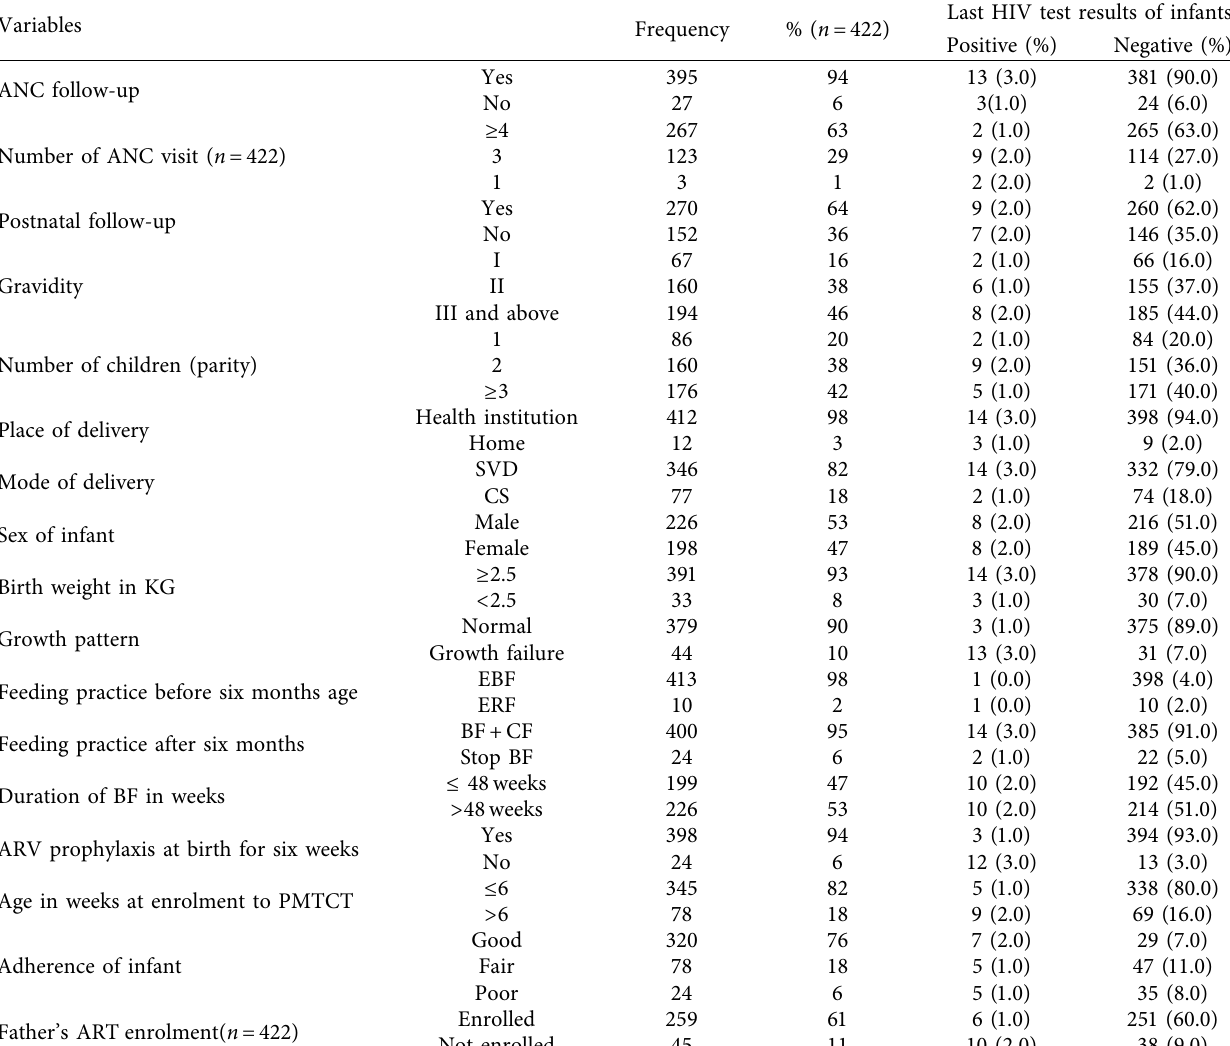
Table 2: Obstetric characteristics and HIV-exposed infant characteristics in general hospitals of West Guji Zone, Oromia, Ethiopia, 2020 ( n �